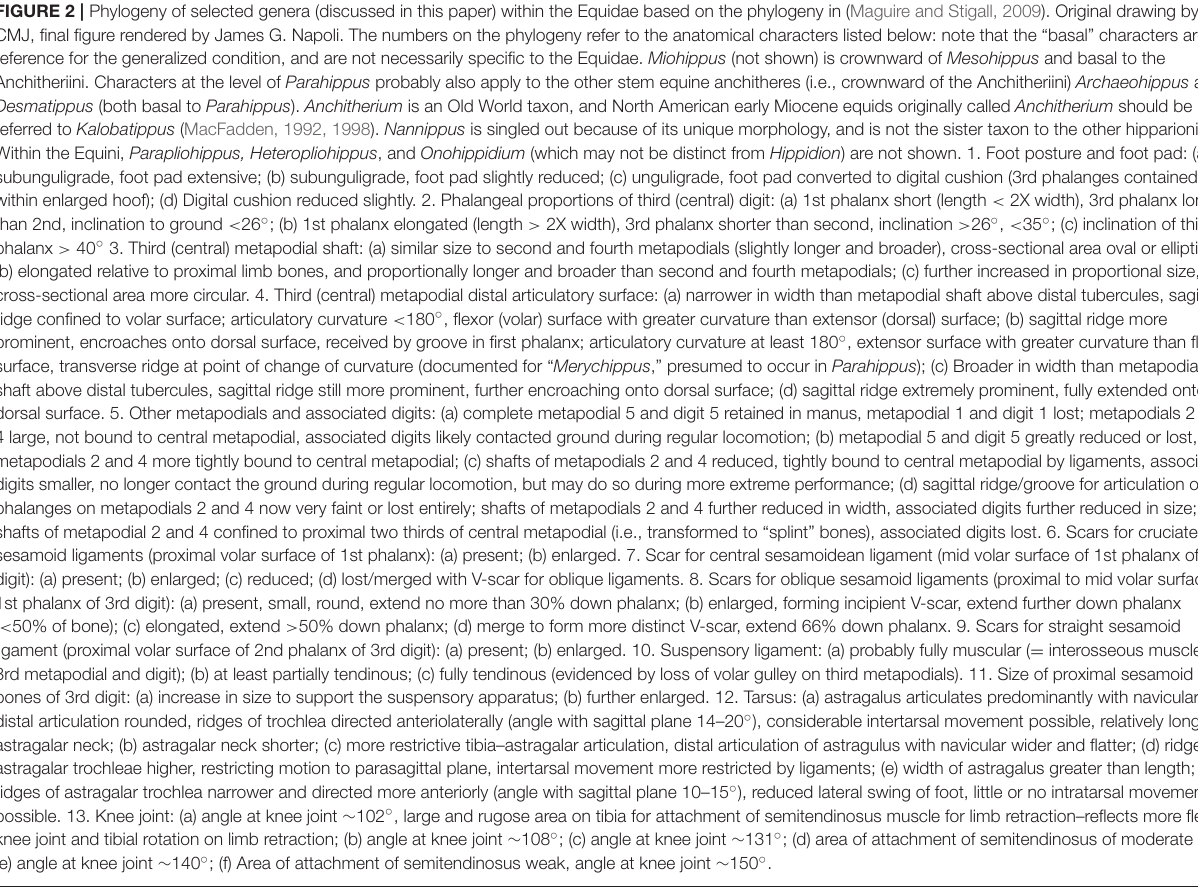
Members of these tribes will be referred to as